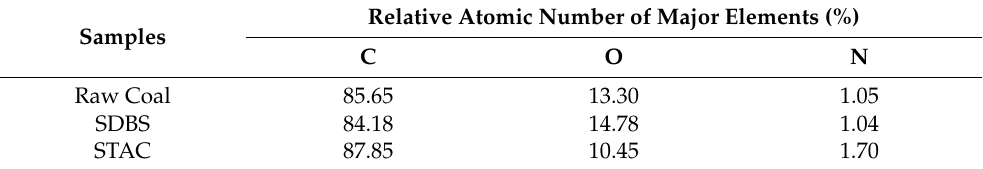
Figure 4. Dynamic change in contact angles of ( a ) SDBS, ( b ) STAC, ( c ) H 2 O and anthracite coal. Table 1. The relative content of the atomic number of the main elements (except H) on the surface of anthracite after